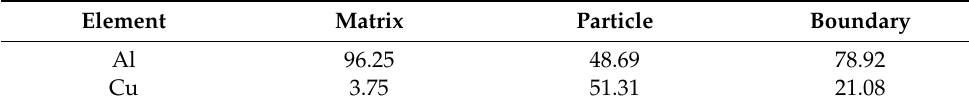
Table 3. EDS analysis results of different areas in Figure 5c (wt.%).